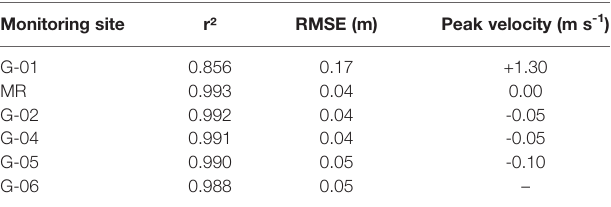
This comparison was made between bottom-mounted velocity measurements and depth averaged velocity predictions except at site MR where depth-averaged ADCP measurements were